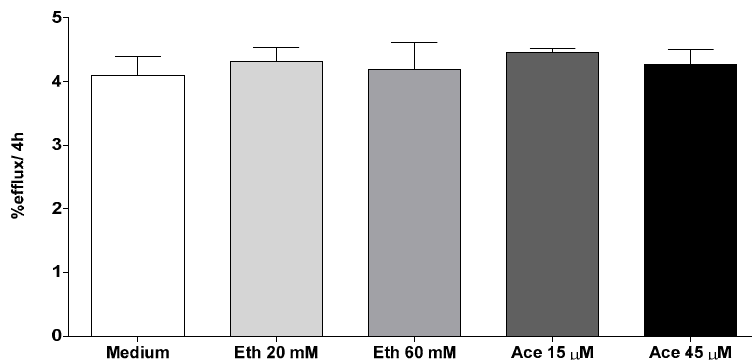
Figure 4. Effect of alcohol (Eth) and acetaldehyde (Ace) on cholesterol efflux from macrophages. MPM were cholesterol enriched with 25 μ g/mL AcLDL and radiolabeled with [ 3 H]-cholesterol 2 μ Ci/mL. Cells were equilibrated in 2% FCS-containing medium and treated with alcohol or acetaldehyde. Cholesterol efflux was promoted to 0.5% mouse plasma for 4 h in presence of acetaldehyde and alcohol as described in the Methods Section. Efflux is expressed as cpm in medium/cpm of time zero × 100 (values are mean of three triplicate). Data are expressed as mean ± SEM. Results were analyzed using one-way ANOVA followed by Tukey’s multiple comparison test among groups.